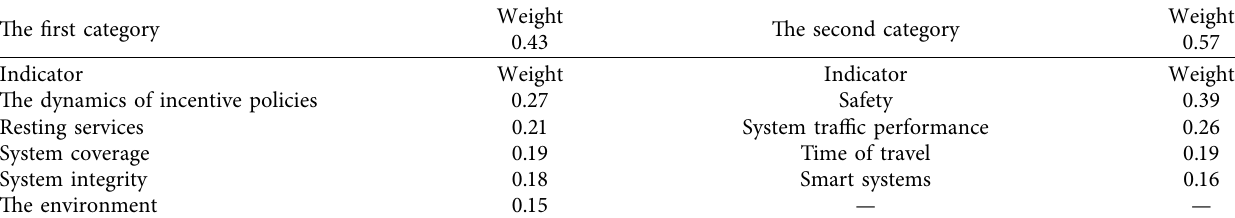
Table 5: Results of weighting the